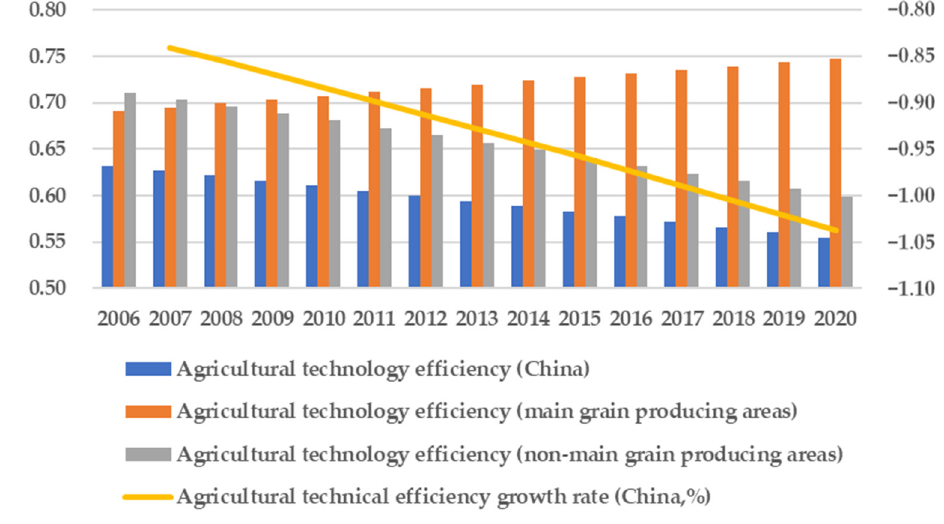
Figure 6. Average technical efficiency of agriculture by region in the period of 2006–2020.